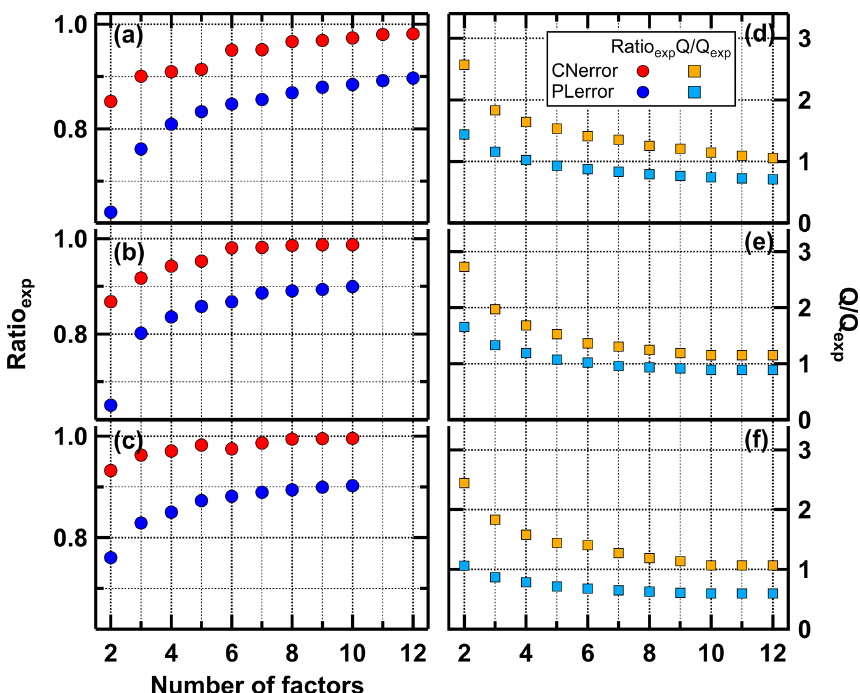
Figure 3. Fraction of explained variance (Ratio exp , a–c ) and Q/Q exp values (d–f) for the low- (a) , medium- (b) , and high-O : C (c) data set for PLerror (blue) and CNerror